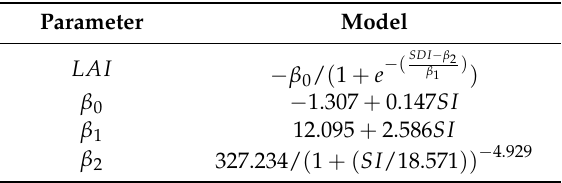
Table 1. Leaf area index ( LAI ) model and parameters for slash